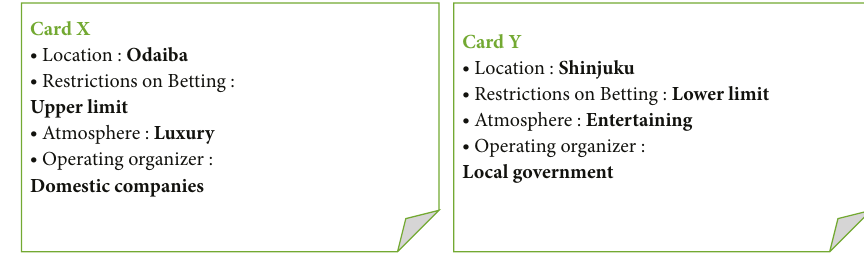
Figure 9: A comparison of two conflicting